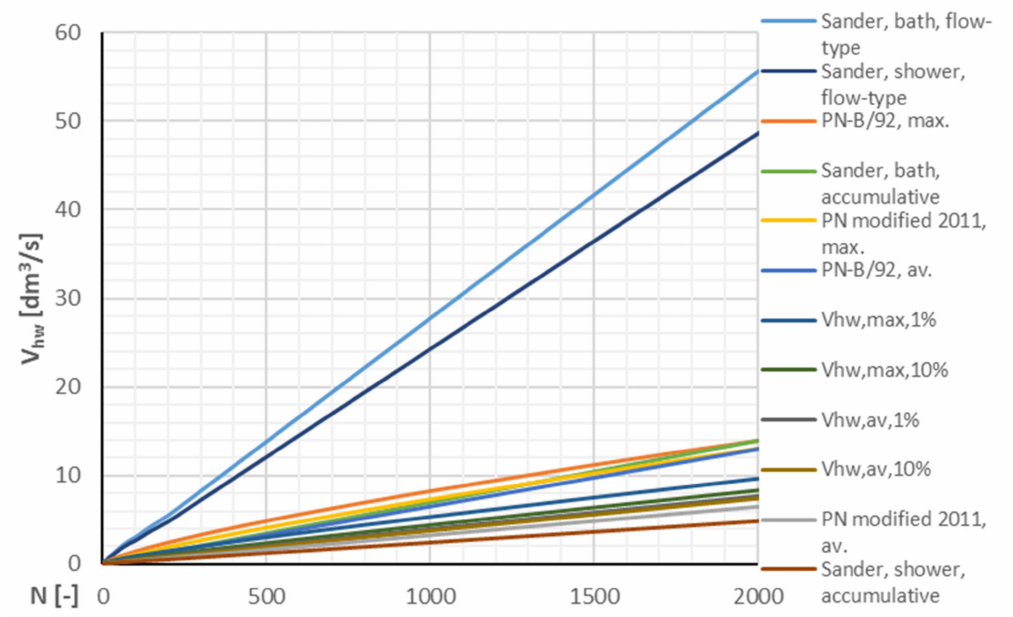
Figure 3. Comparison of hot water consumption calculated with different formulas, the number of flats: N = 0–2000.